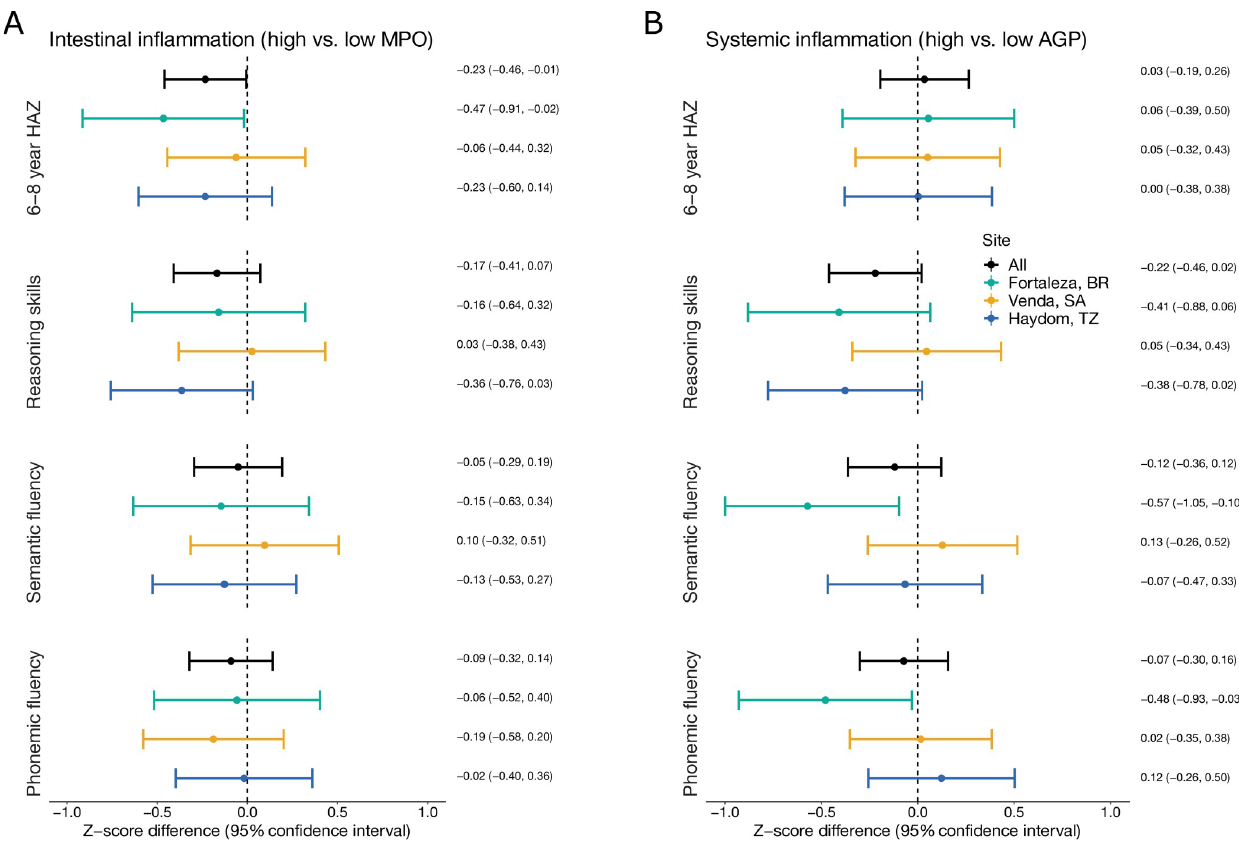
Fig 2. Associations between intestinal (A) and systemic (B) inflammation in the first 2 years of life with linear growth and cognitive outcomes at 6–8 years of age among 451 children in the Brazil, South Africa, and Tanzania MAL-ED cohorts. Mean Z-score difference estimates and 95% confidence intervals were derived from linear regression models adjusting for site, age at the 6–8 year assessment, enrollment weight-for-age z-score (or enrollment length-for-age z- score for height outcomes), sex, socioeconomic status, exclusive breastfeeding in the first 6 months, maternal height, and the burden of each of the 12 most prevalent pathogens identified in the first 2 years of life (excluding Shigella